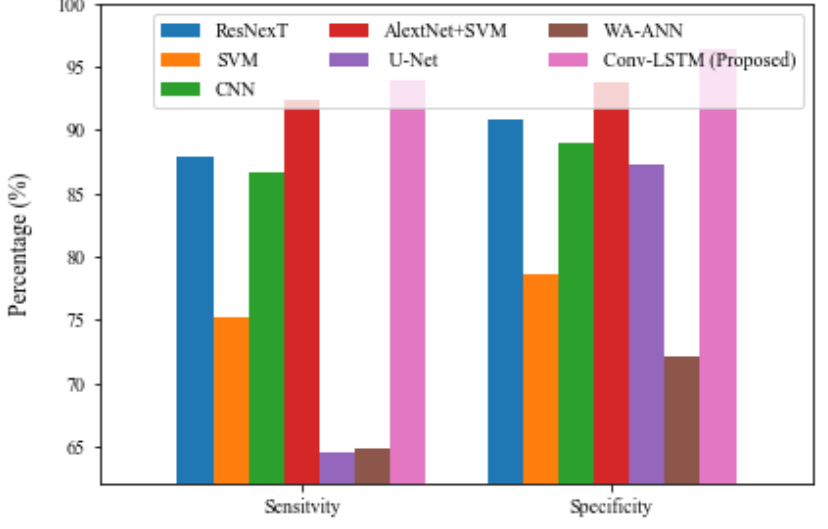
87.63%, respectively. Although these two models attempted to produce better results, they were unable to categorize the photos containing the bleeding. Figure 9. Comparative result analysis of Conv-LSTM with Sensitivity and Specificity.